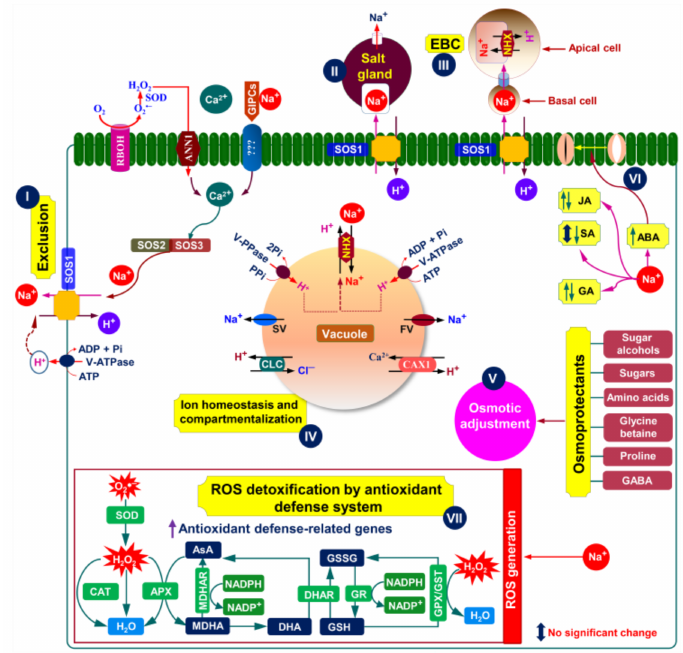
Figure 3. Putative salt tolerance mechanisms in an ideal halophyte plant (modified from Zhao et al. [11], Arif et al. [34], Arbelet-Bonnin et al. [72], Tran et al. [75], and Himabindu et al. [76]. The absorption of Na + in plant cells is counterbalanced by active Na + extrusion through SOS1 Na + /H + exchanger ( I ). The RBOH-mediated ROS formation in the plasma membrane can activate ANN1- induced Ca 2+ -signaling pathway ( I ). The Na + bound GIPCs can trigger Ca 2+ influx through an unknown Ca 2+ channel ( I ). Ca 2+ influx mediated by either ANN1 or GIPCs is essential for activating the SOS-signaling pathway ( I ). The SOS3 relays salt-triggered Ca 2+ signals to SOS2 kinase, forming the SOS3-SOS2 protein complex that phosphorylates SOS1 to induce Na + efflux ( I ). To maintain ion homeostasis, halophytes can also sequestrate excess Na + into the vacuoles and/or excrete Na + via two unique structures, namely salt glands and salt bladders ( II and III ). It is also possible to avoid excessive Na + accumulation in the cytosol by sequestrating it into the vacuoles ( IV ). Predominantly, Na + -sequestration in the vacuoles is conferred by tonoplast-based Na + /H + exchangers of the NHX family (e.g., NHX1 or NHX2), fueled by either H + -PPase or H + -ATPase pumps ( IV ). Another equally important mechanism of vacuolar Na + -sequestration is the efficient control of tonoplast slow vacuolar (SV) and fast vacuolar (FV) activating ion channels, which may allow vacuolar Na + to leak back into the cytosol ( IV ). Once, if both channels are downregulated or blocked by choline, Na + leakage is inhibited, resulting in an increased level of salt tolerance ( IV ). On the other hand, Cl − influx in the vacuoles is mediated by CLC ( IV ). To maintain cytosolic Ca 2+ homeostasis under saline conditions, the influx of Ca 2+ into the vacuole is mediated by CAX1 ( IV ). In response to salt stress, halophytes often accumulate various osmoprotectants, including proline, total free amino acids, sugars, polyols, glycine betaine, and GABA, which play vital roles in conferring an efficient osmotic adjustment ( V ). In addition, changes in the levels of different phytohormones may also help in stress adaptation; for instance, increased ABA level aids in controlling stomatal closure to maintain better water status at the tissue level ( VI ). It is worth mentioning that changes in the levels of phytohormones (e.g., JA, SA, and GA) in halophytes under salt stress varies dependently on the type of halophytes ( VI ). Furthermore, excessive salt accumulation can trigger oxidative stress via overproduction of ROS, such as O 2 • – and H 2 O 2 ( VII ). To fight against ROS-mediated oxidative damage, halophytes induce a vibrant antioxidant defense system by activating both enzymatic (SOD, CAT, APX, MDHAR, DHAR, GR, GPX, and GST) and non-enzymatic (AsA and GSH) antioxidants ( VII ). Abbreviations: ABA, abscisic acid; ANN1, annexin1; APX, ascorbate peroxidase; AsA, ascorbic acid; CAT, catalase; CAX, Ca 2+ /H + exchanger; CLC, chloride channel (H + /Cl – antiporter); DHA, dehydroascorbate; DHAR, dehydroascorbate reductase; EBC, epidermal bladder cell; GA, gibberellic acid; GIPC,